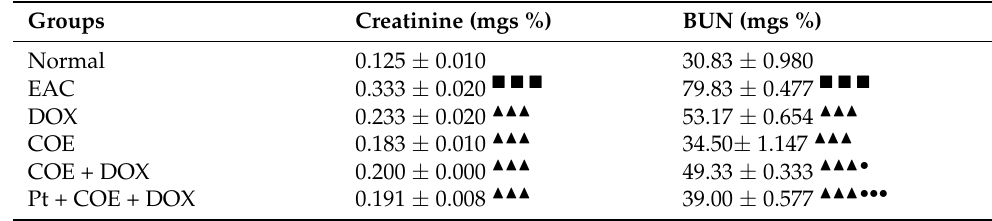
Table 5. Effect of COE on creatinine and